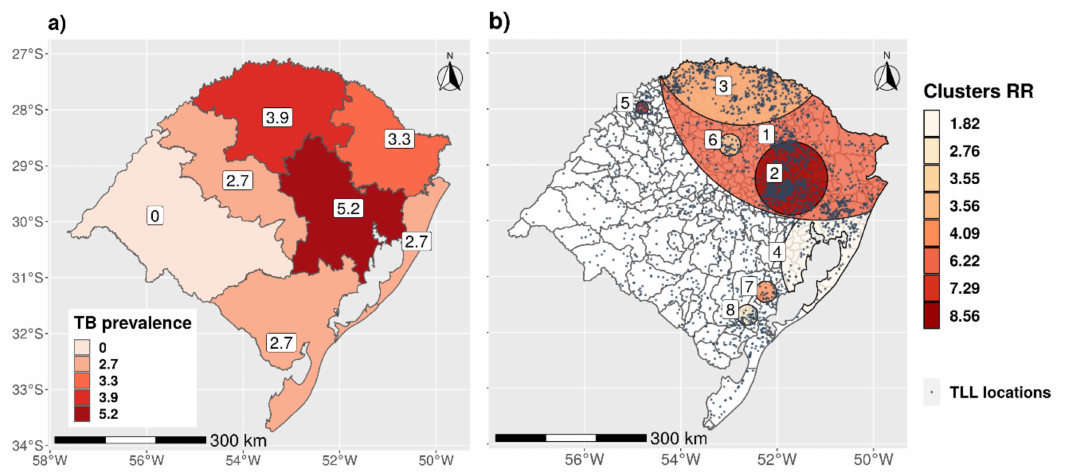
Figure 6. ( a ) Map of prevalence of TB by productive regions in RS (Adapted from [16]) ( b ) Clusters of TLL locations (premises with reported TLL) for the RS state for all of the study period. The blue dots represents the premises